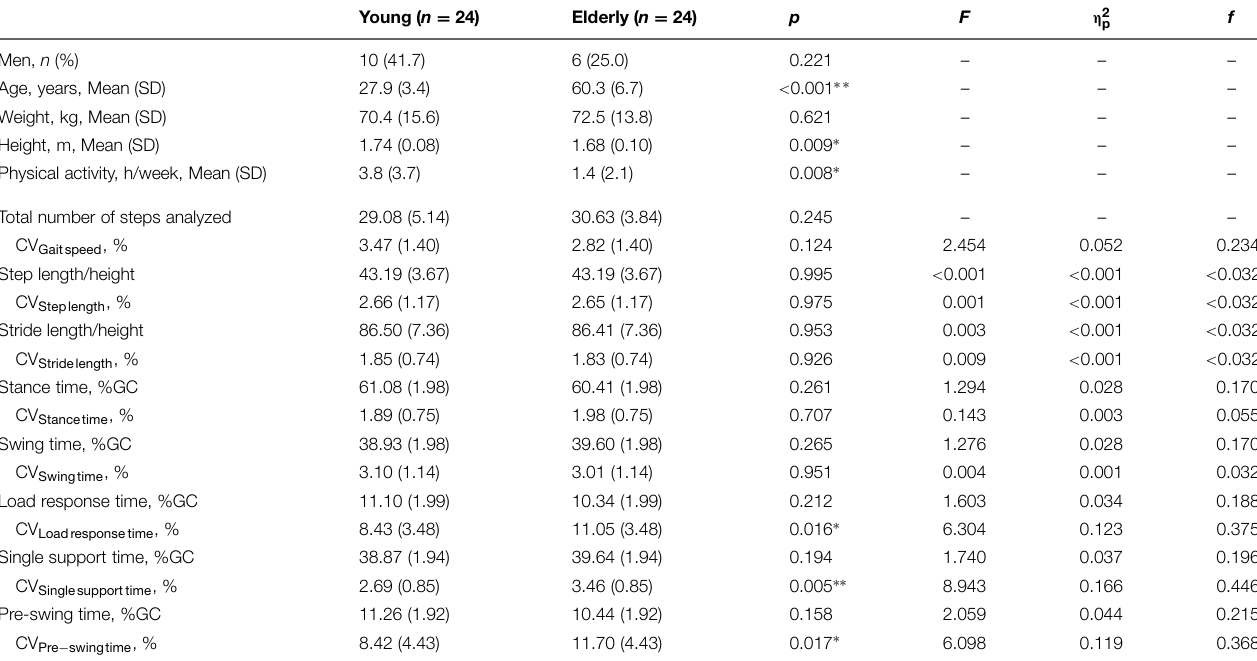
TABLE 2 | Experiment 2 – Demographic subject characteristics, spatio-temporal and temporophasic gait parameters of healthy young and elderly